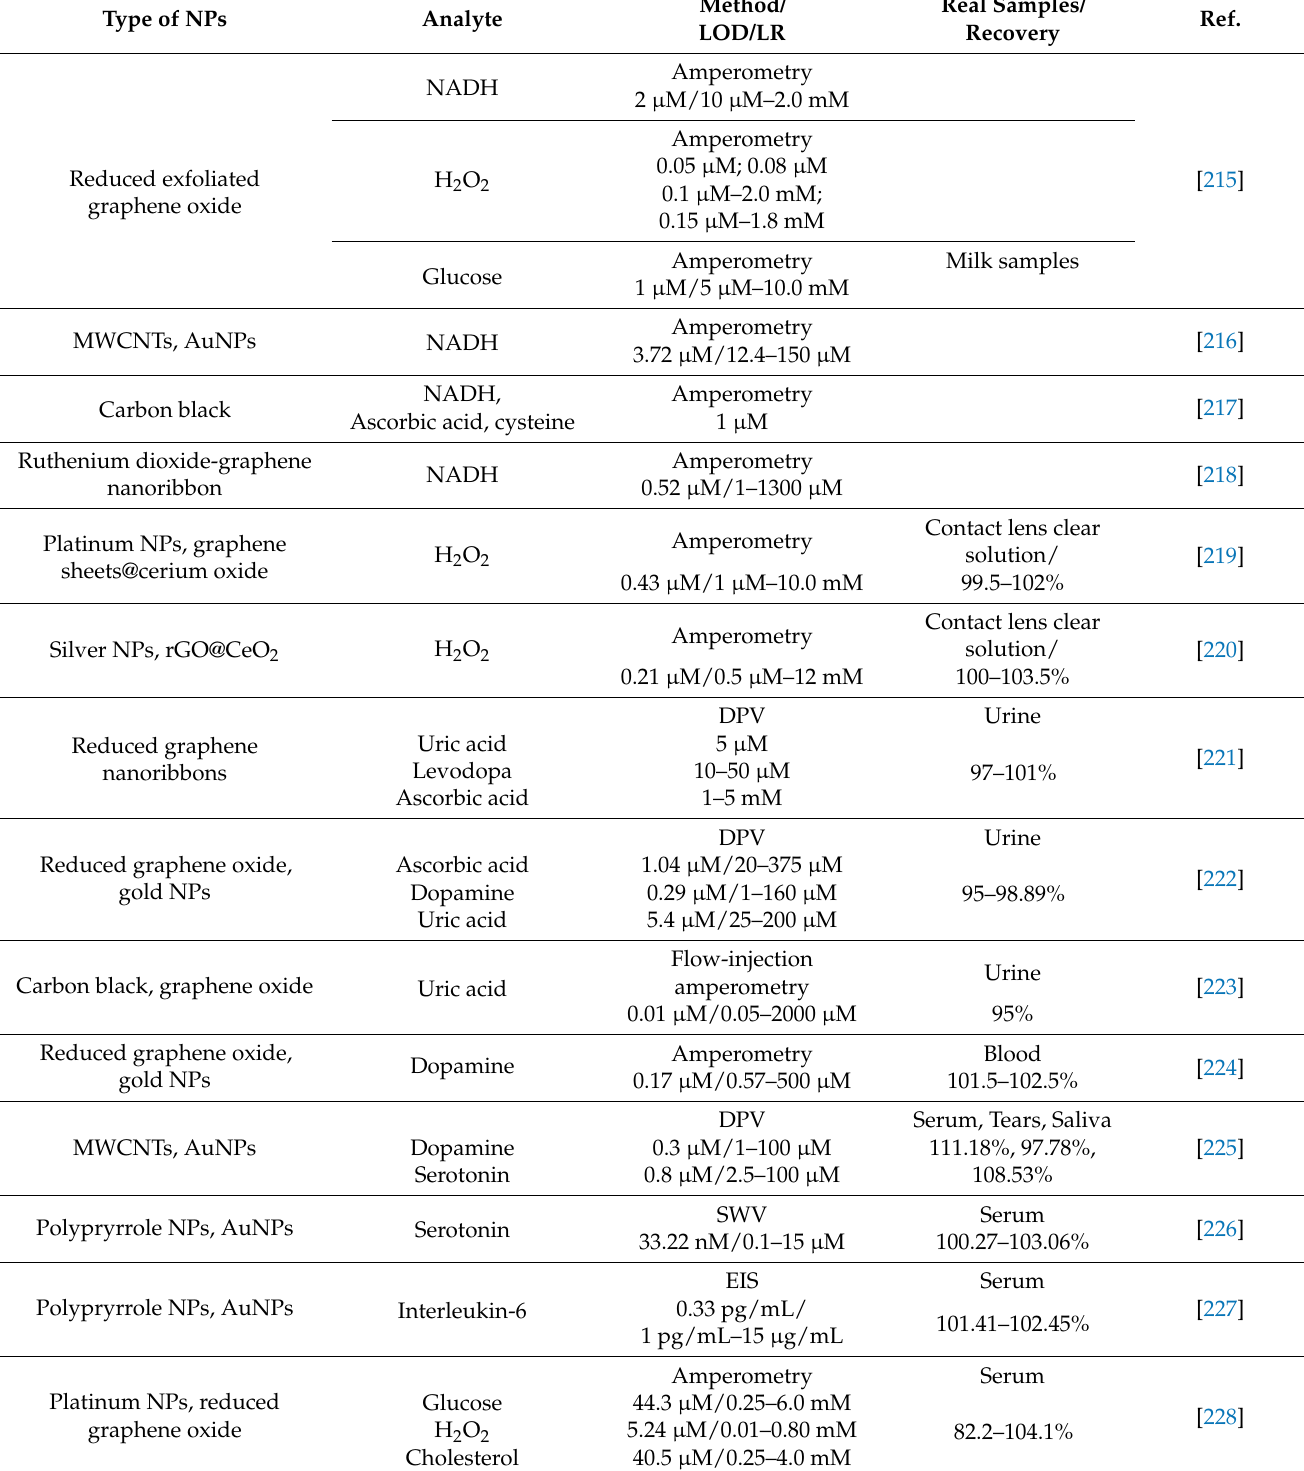
Table 1. Screen-printed electrodes modified with various nanomaterials for medical applications (some